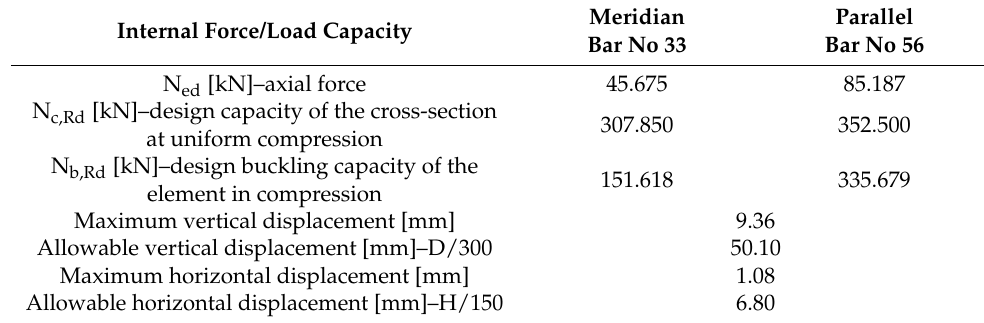
Table 1. Values of cross-sectional forces and load capacities for the most stressed structure elements